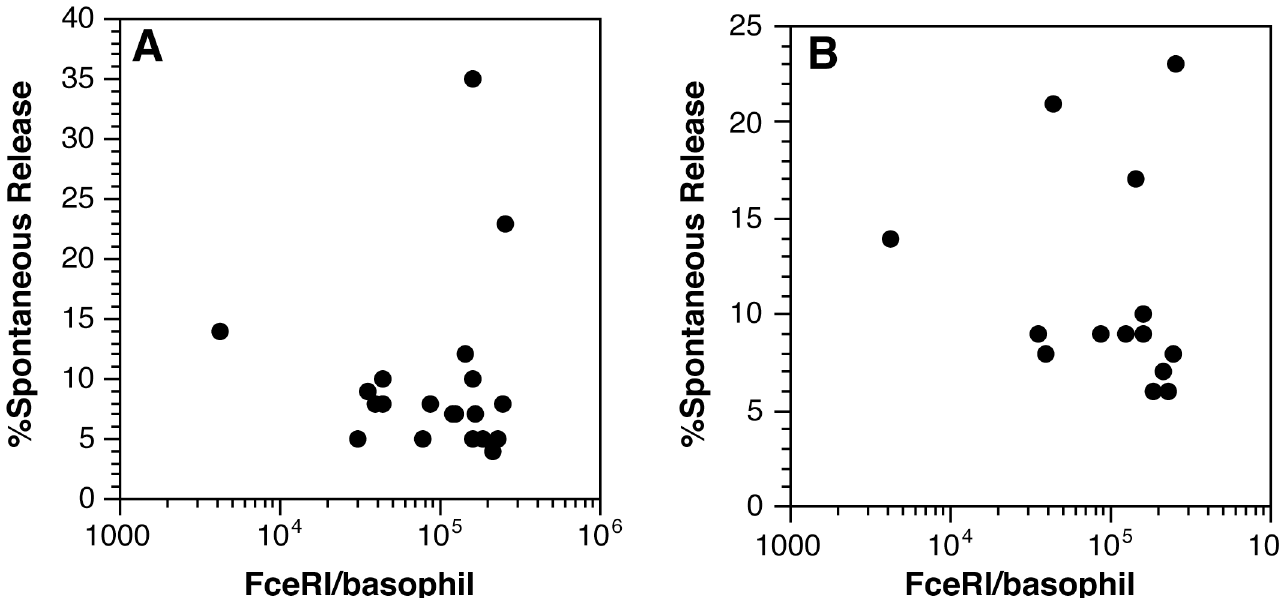
Fig 2. Correlations between FceRI density and in vitro spontaneous histamine releasefrom human basophils. Panel A, normalbuffer; Panel B, D2O in buffer. (Some experiments in this survey did not includeD2O).